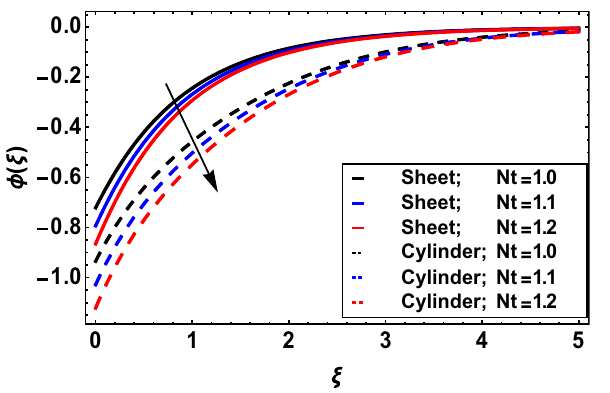
Figure 13: Change in nano fl uid concentration due to Nt .